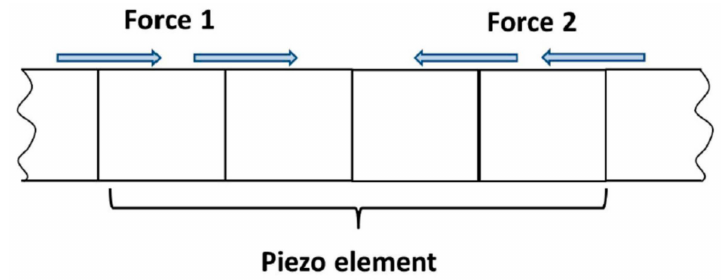
Figure 5. Simplified piezo-model used for the HF ultrasonic